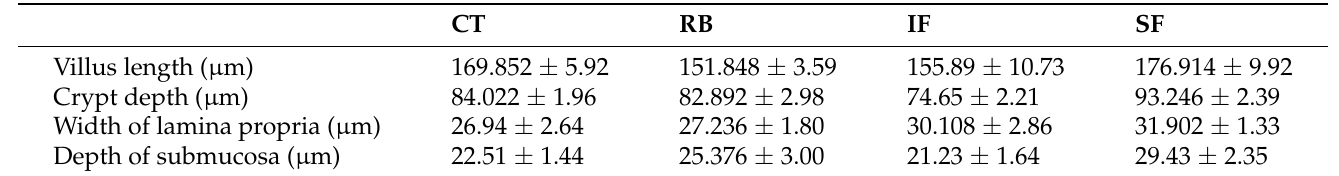
Table 4. Morphological features of ileum tissues ( mean of 5 replicates ± standard error, CT = control, RB = rice beverage, IF = insoluble fraction, and SF = soluble fraction).